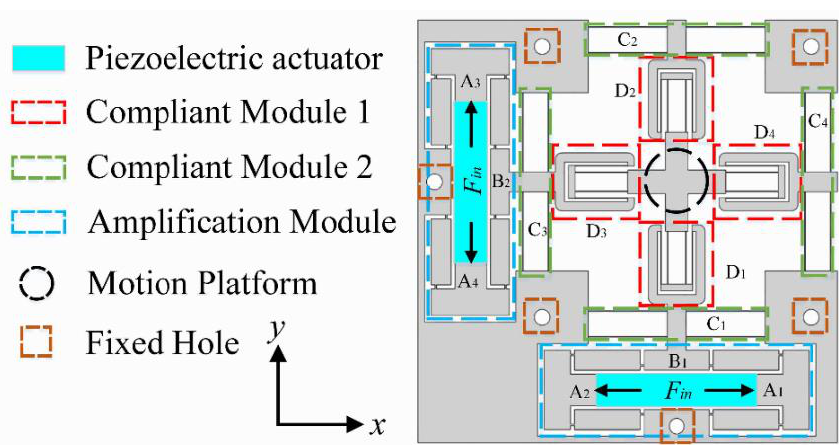
Figure 1. Mechanical design of compliant positioning stage.